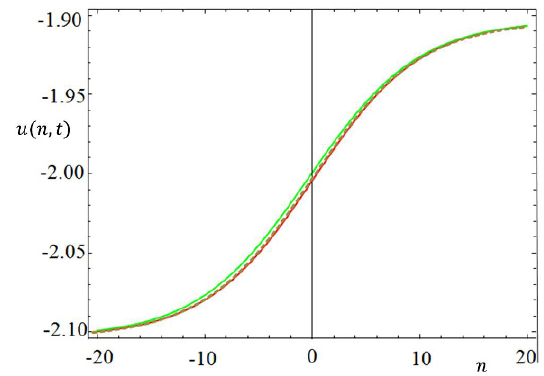
Figure 7. Explicit numerical solutions of Eq. (42) for u (65) at µ = 1 , λ = 1 . Redline µ = 1 , λ = 3 ; Dashed line with c = 0 . 1 , d = 0 . 1 and µ = 3 5 5 t = 0 . 15 .